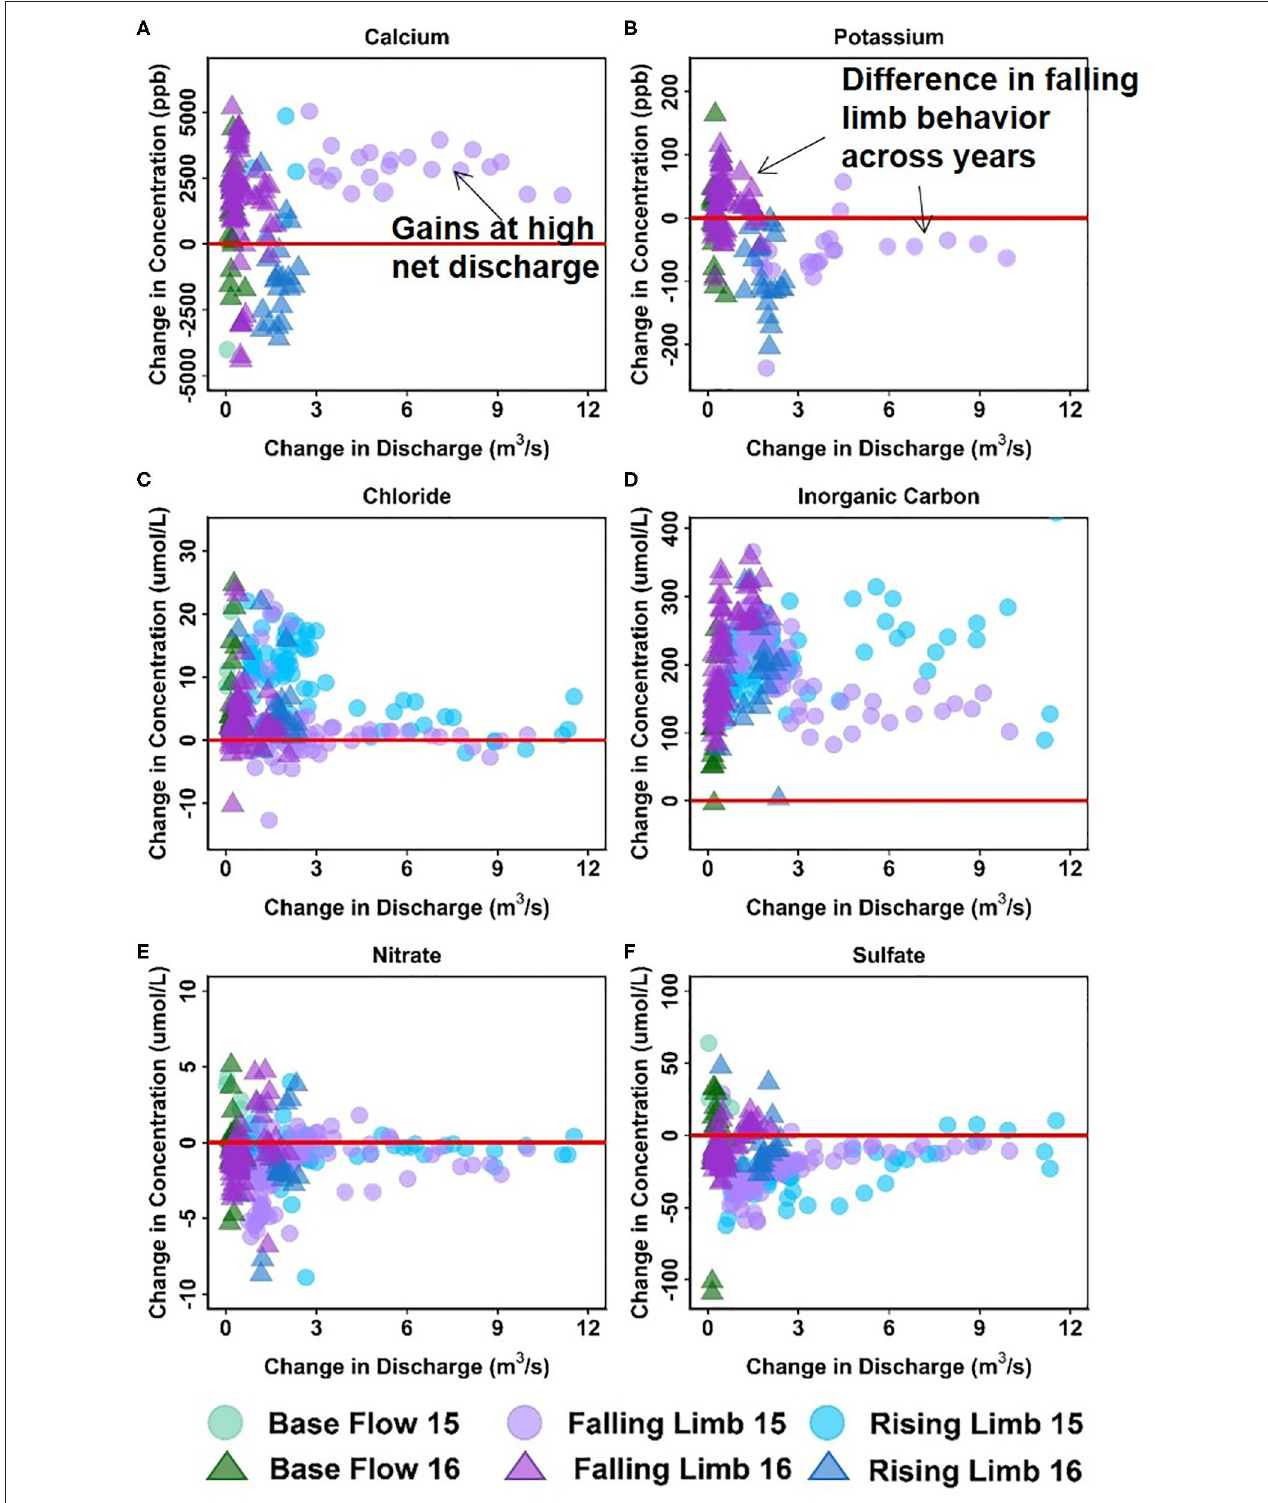
FIGURE 7 | Differential C-Q analyses for the downstream reach showing changes in concentrations of (A) Ca, (B) K, (C) Cl, (D) DIC, (E) NO 3 , and (F) SO 4 relative to changes in flow. For clarity, gains and losses of solutes are demarcated relative to a solid red “no change” line.